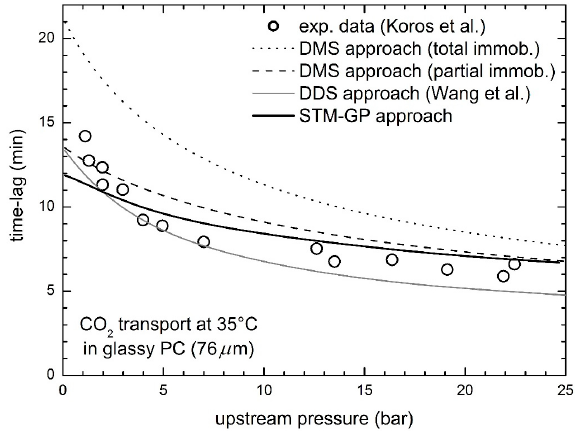
Figure 3. Diffusional time lag for CO 2 transport in glassy PC at 35 °C: experimental data by Koros et al. [50] and STM-GP model predictions.